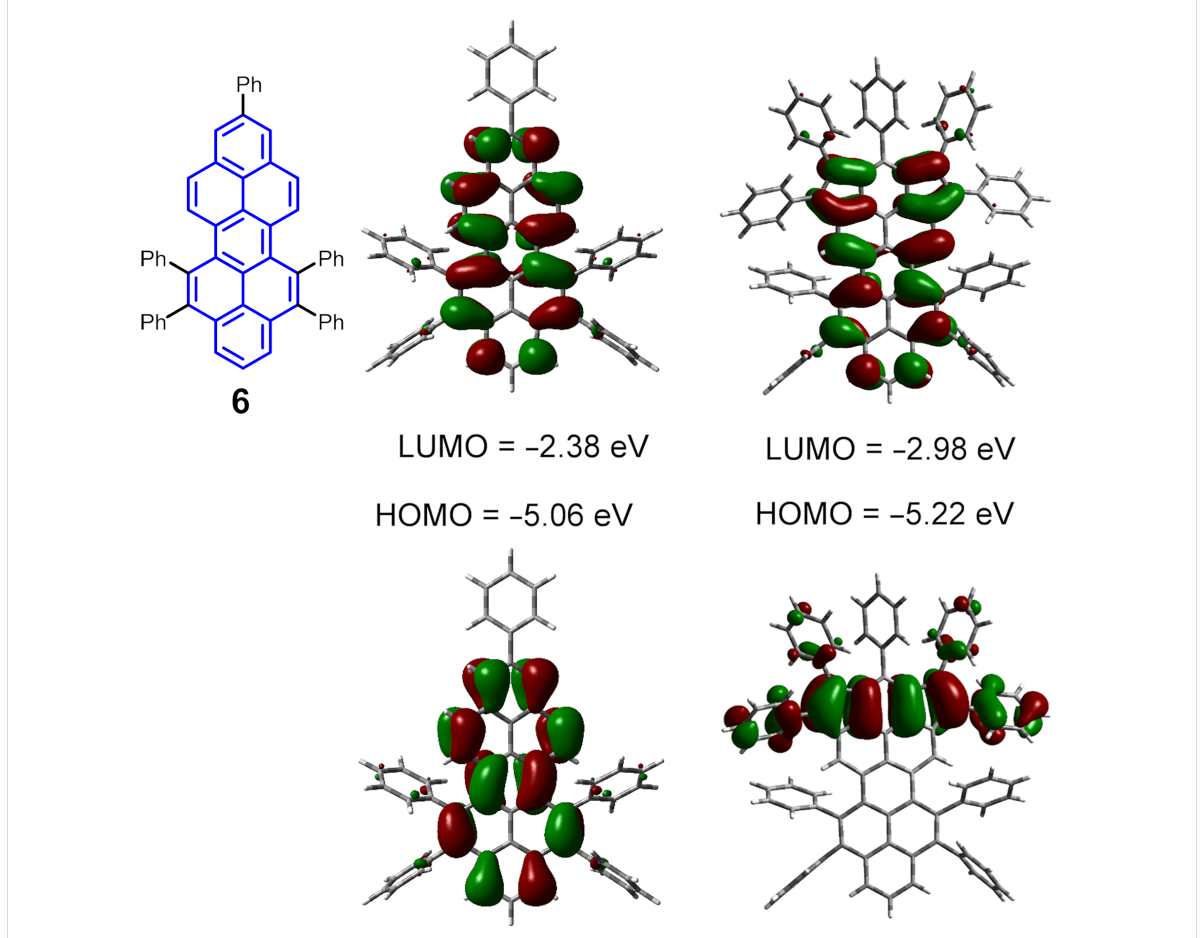
Figure 4: Molecular orbitals of peropyrene derivative 6 and the dicyclopenta-fused peropyrene 1 .